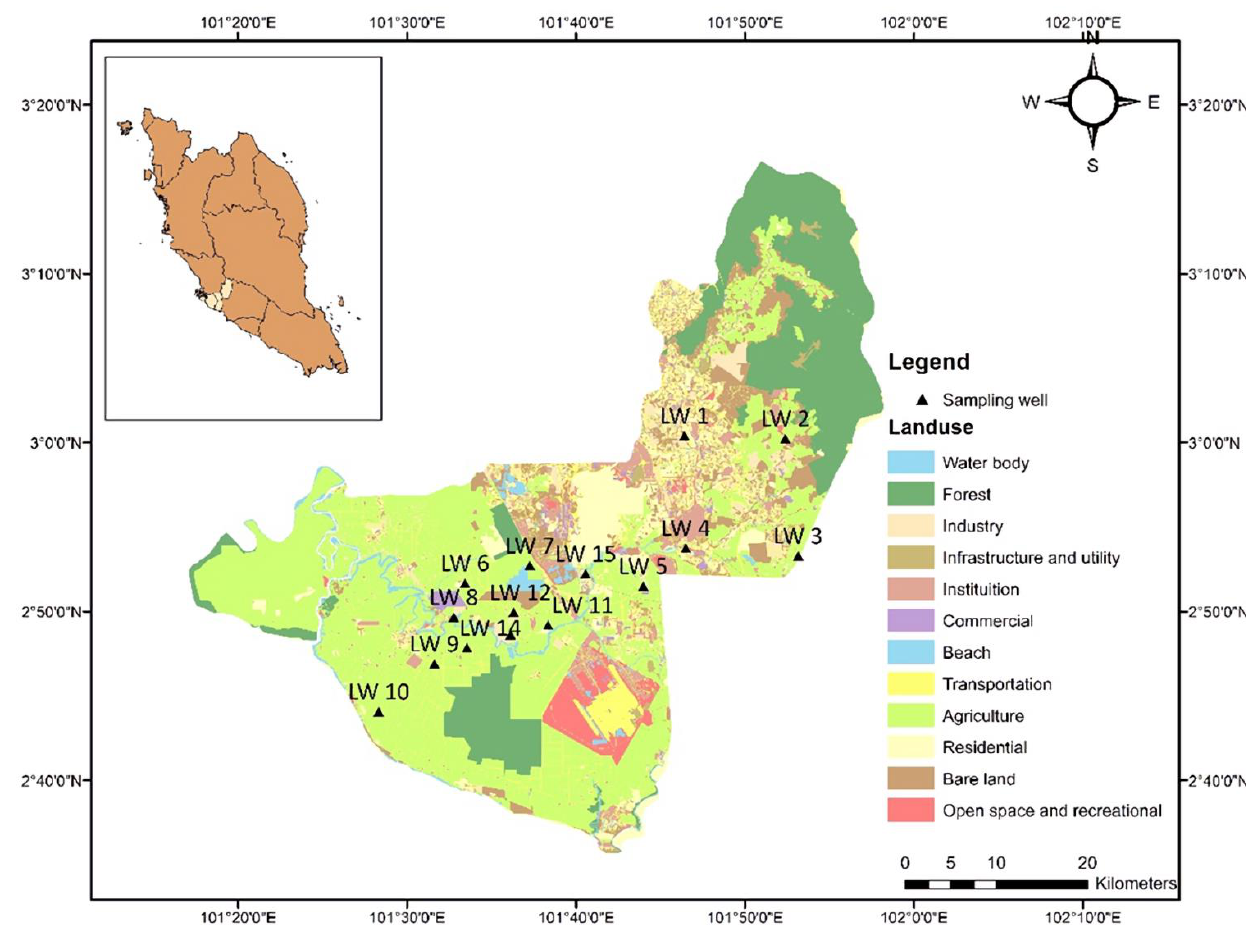
Figure 1. The land use map of the Langat basin.